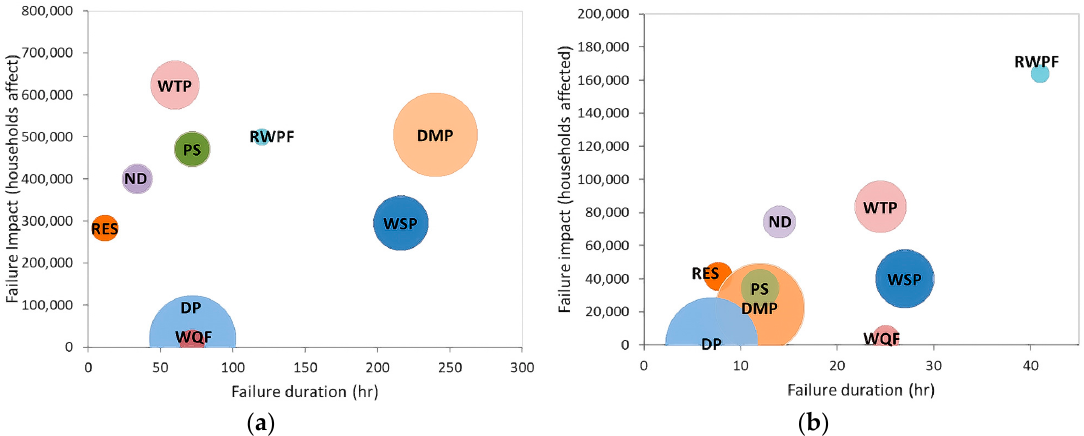
Figure 5. CID bubble plots with the center of the bubble positioned at ( a ) the maximum, and ( b ) the average value of the failure duration and impact. Their radius is proportional to the failure event’s frequency in Table 2.